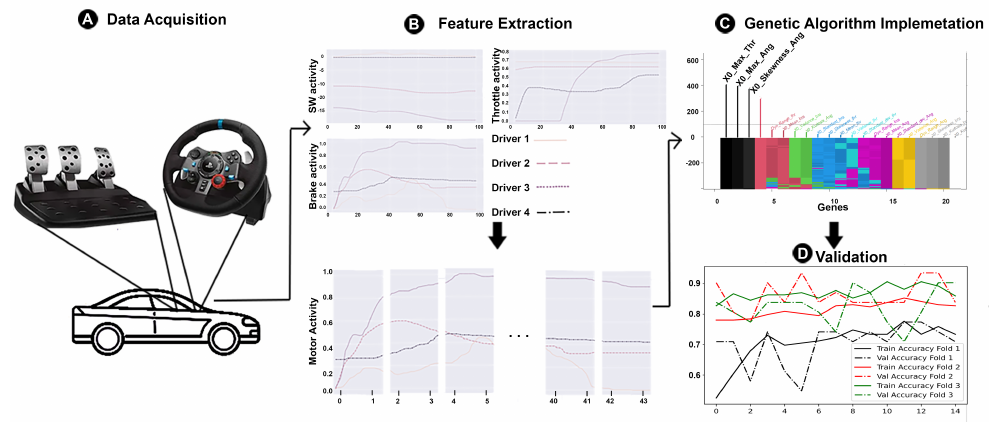
Figure 1. Proposed methodology for the objective identification of drivers by their motor activity based on a genetic algorithm